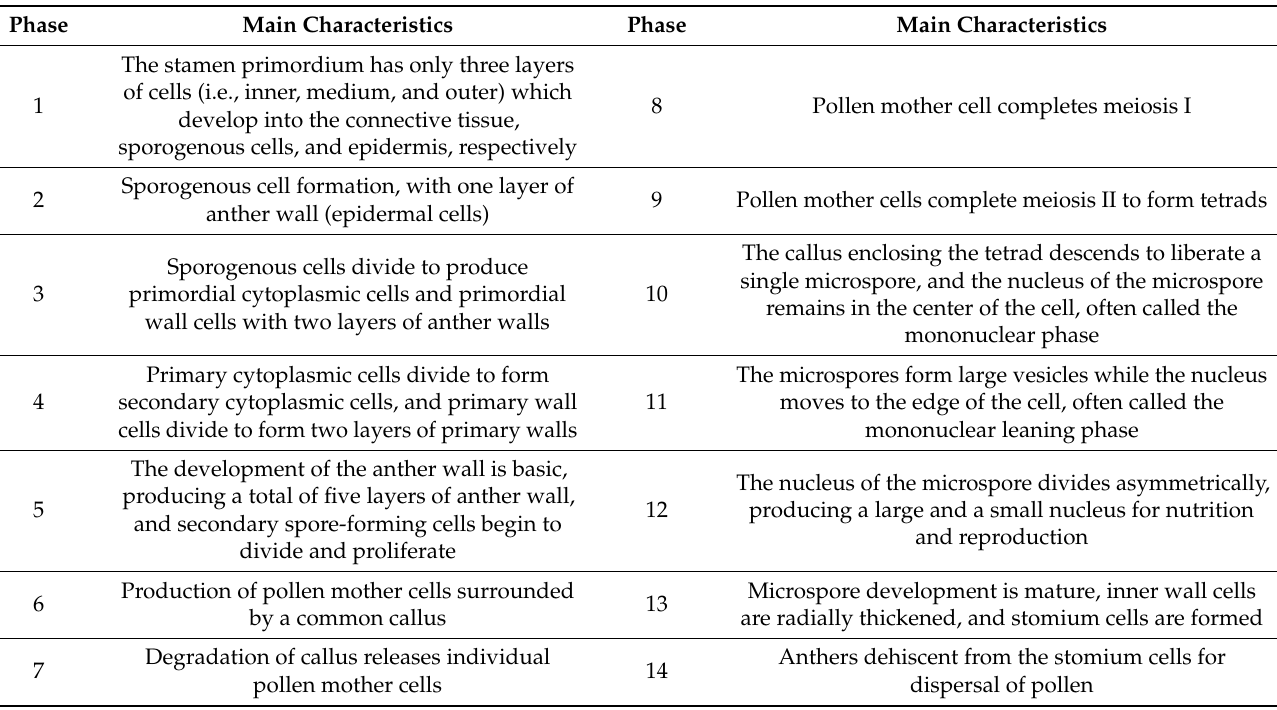
Table 1. Classification of the developmental stages of C. oleifera